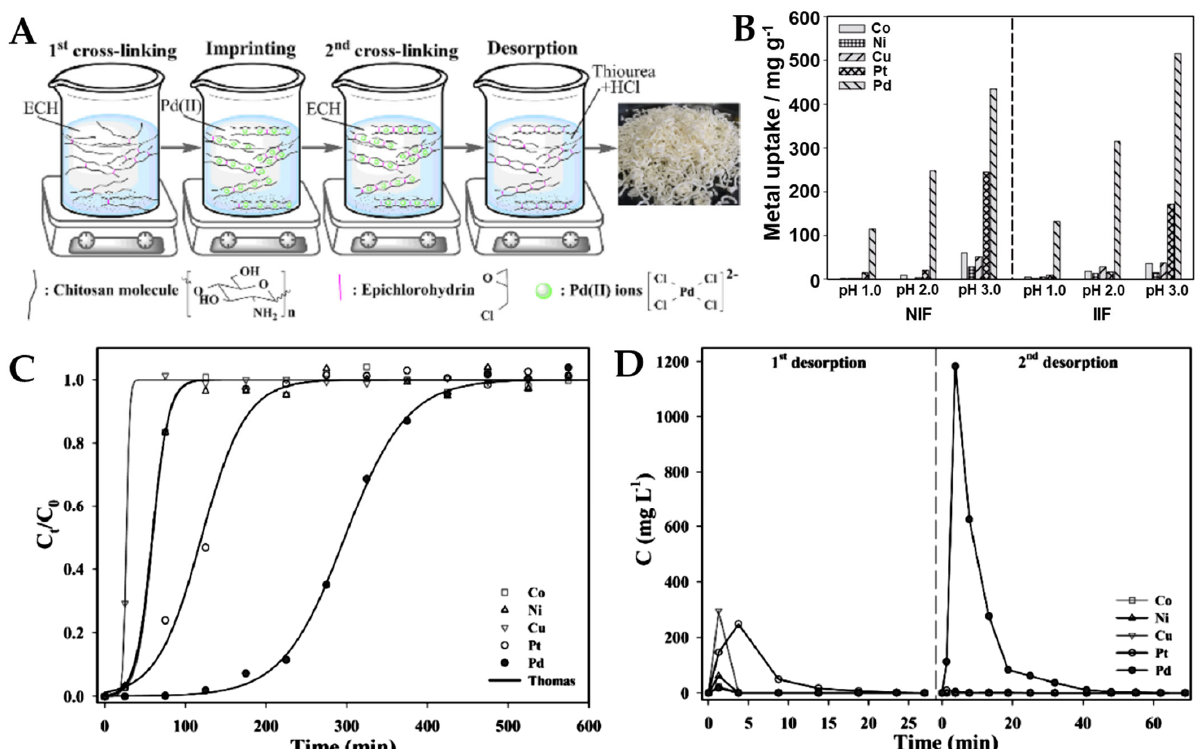
Figure 18. ( A ) Illustration with the Pd(II)-imprinted CS fibers by double ECH cross-linking. (Reproduced with permission from Ref. [178]). ( B ) The effect of equilibrium pH on the sorption of metal ions by non-imprinted (NIF) and Pd(II)-imprinted (IIF) CS fibers. (Reproduced with permission from Ref. [179]. Copyright 2015 Elsevier) Column adsorption ( C ) and desorption ( D ) of Pd(II), Co(II), Ni(II), Cu(II), and Pt(IV) from hydrometallurgy wastewater onto the Pd(II)-imprinted CS fibers. (Reproduced with permission from Ref. [180]. Copyright 2020 Elsevier).